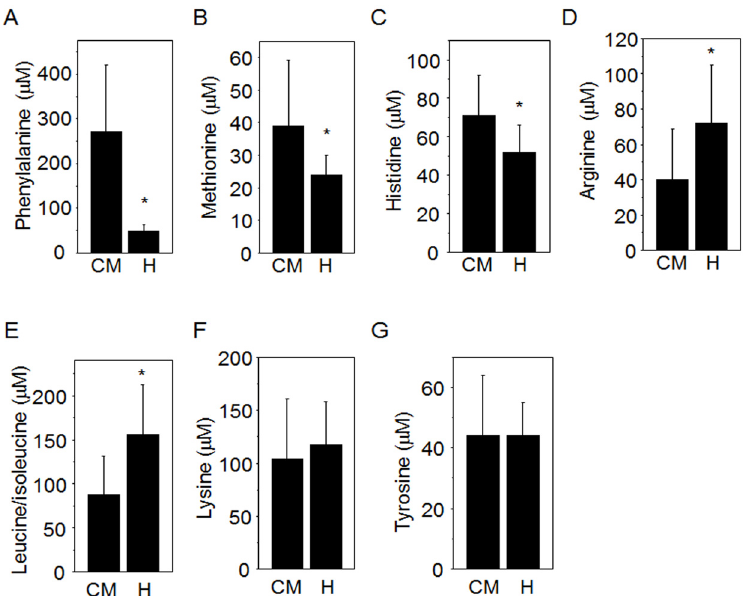
Fig 1. Plasma levels of amino acids in common marmosets and human. Plasma of common marmosets including female and male marmosets (n = 50) was analyzed for amino acids by LCMS to compare with values of human plasma (H). Concentration of phenylalanine (A) and methionine (B), histidine (C) of common marmoset (CM, mean ± SD) were significantly higher than human. Arginine (D) and leucine/isoleucine (E) were significantly lower in CM than H. Lysine (F) and tyrosine (G) values of CM were not significantly different from H (Mean ± SD). * p < 0.05.